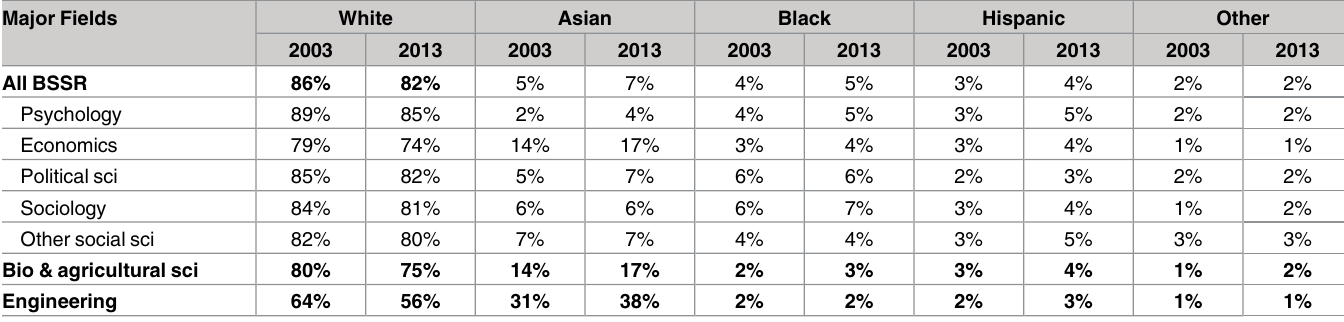
Table 2. Demographic trends in the BSSR workforce by race. Major